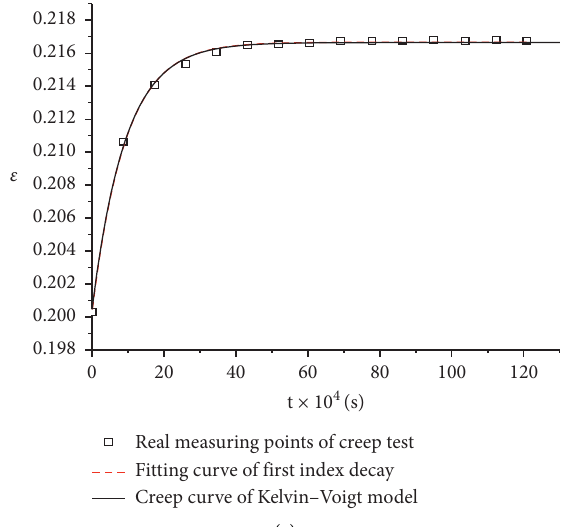
Figure 7: Kelvin–Voigt model and the fitting curve of first index decay of fragmentized coals with different grain sizes. (a) m1. (b) m2. (c) m3. (d) m4. (e) m5.